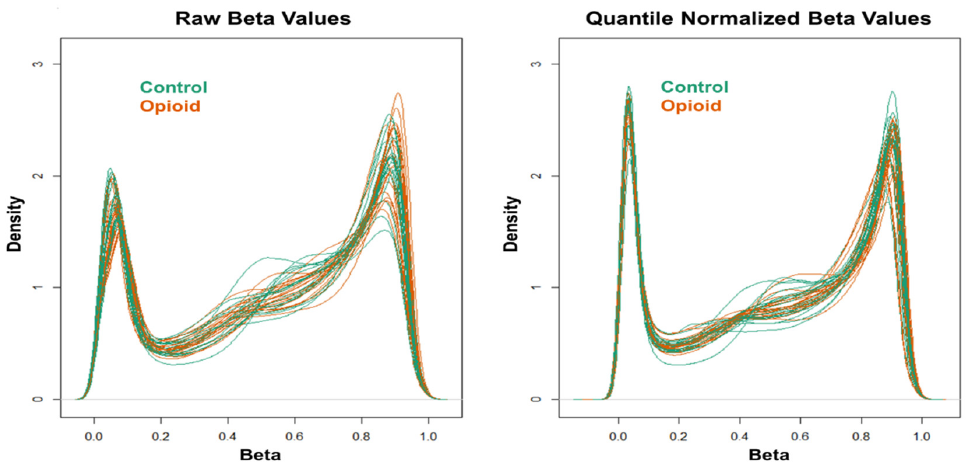
Figure 1. Density plots of raw ( left ) and quantile-normalized ( right ) beta values from opioid-exposed ( n = 19) and control ( n = 20) samples.